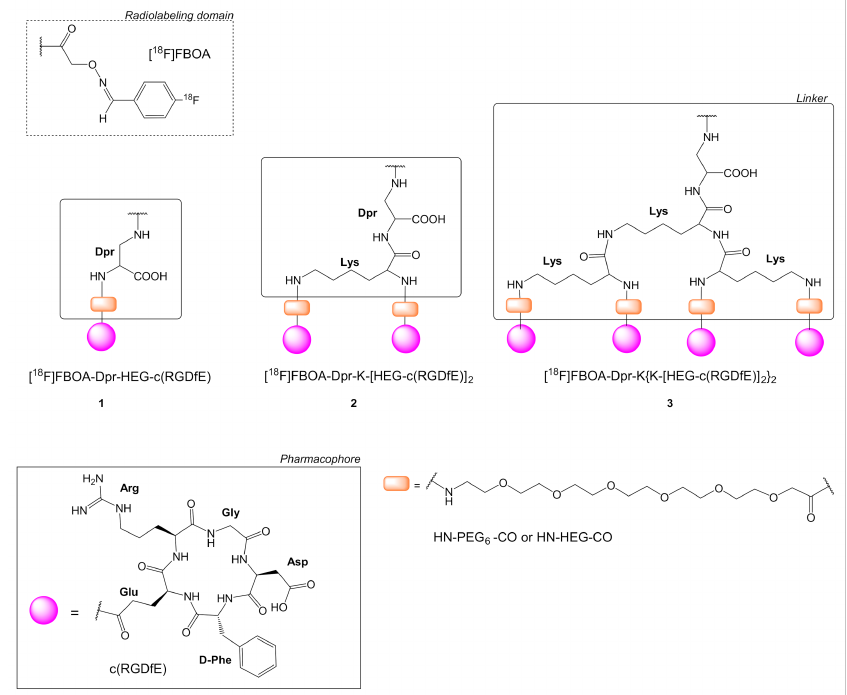
Figure 2. Chemical structures of c(RGDfE) peptides with a PEG 6 linker (H 2 N-PEG 6 - CH 2 COOH); monomer [ 18 F]FBOA-Dpr-HEG-c(RGDfE) 1 , dimer [ 18 F]FBOA-Dpr-K(HEG- c(RGDfE)) 2 2 and tetramer [ 18 F]FBOA-Dpr-K{K[HEG-(c(RGDfE)] 2 } 2 3 are labeled with N -(4-